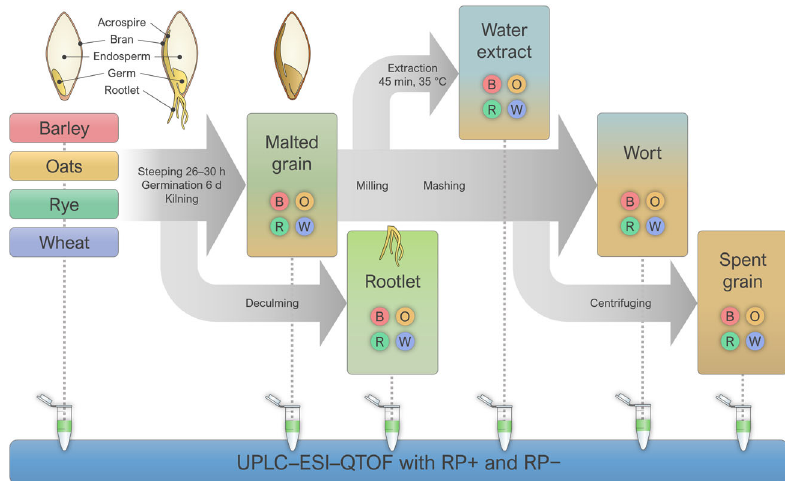
Fig. 1 Scheme of the malting, extraction, mashing, and wort separation processes utilized in the study. Intact (native) grains from four cereal species were used throughout the process. The changes in the structure of the grain and the parts used for different stages of the process are